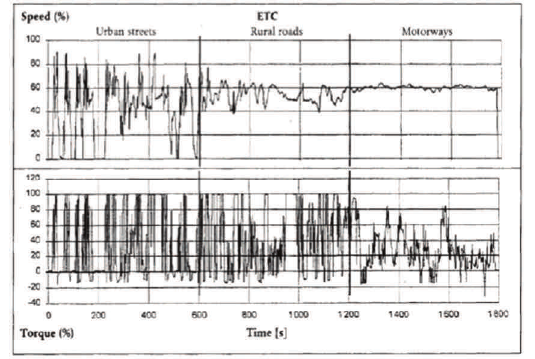
Fig. 4. European ESC cycle [9]